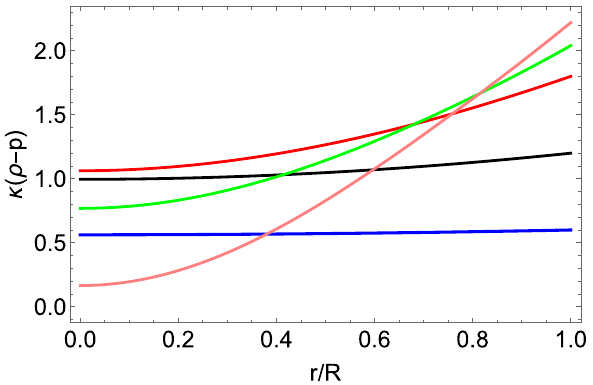
Fig. 4 ρ − p for u = 0 . 1 (blue line), u = 0 . 2 (black line), u = 0 . 3 (red line), u = 0 . 34 (green line), u = 0 . 37 (pink line) and (cid:13) =